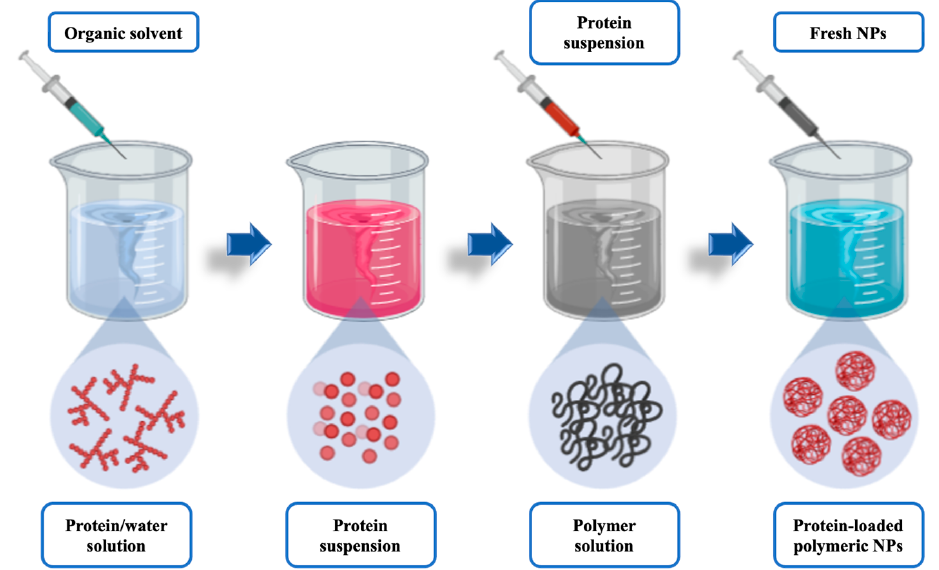
Figure 2. Simplified representation of the PLGA-based nanocapsules elaboration process.